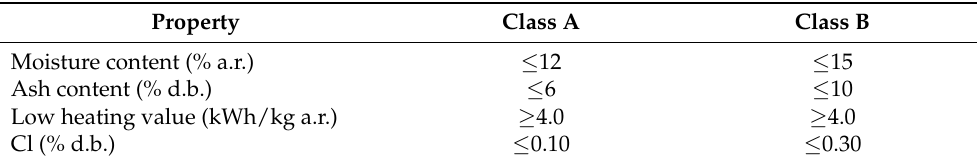
Table 1. Properties of non-woody pellets (mixed pellets included) according to ISO 17225-6 (% a.r.: weight percentage as received; % d.b.: weight percentage in dry